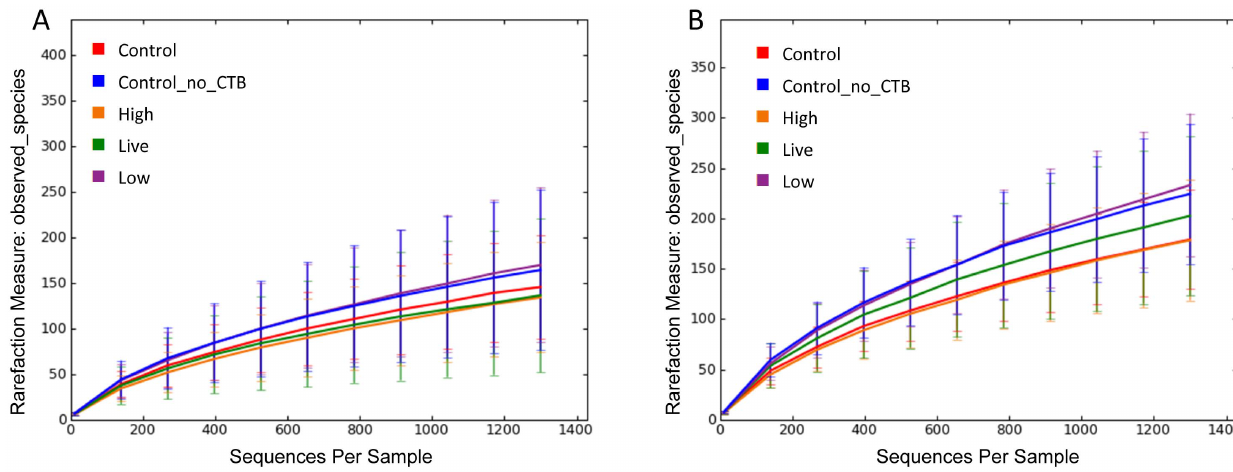
Figure 1. Rarefaction analysis of 16 S rRNA gene sequences obtained from fecal swabs from foals. Lines represent the average of each vaccination group at all ages (panel A) or at 30 days only (panel B), while the error bars represent the standard deviations. The analysis was performed on a randomly selected subset of 1,300 sequences per sample and included samples from 42 foals. Note that both the greatest and least number of species observed occurred among foals that received no enteral bacteria (live or inactivated), indicating an absence of evidence of treatment effect. Control = control plus CTB group; Control_no_CTO = control without CTB group; High = high-dose inactivated R. equi group; Live = live R. equi group; Low = low-dose inactivated R. equi group.